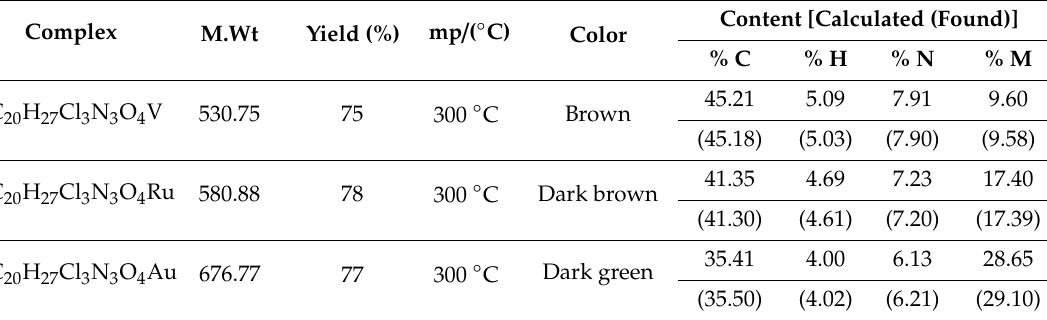
Table 1. Elemental analysis and physical properties of papaverine metal complexes. Complex M.Wt Yield (%) mp / ( ◦ C) Color